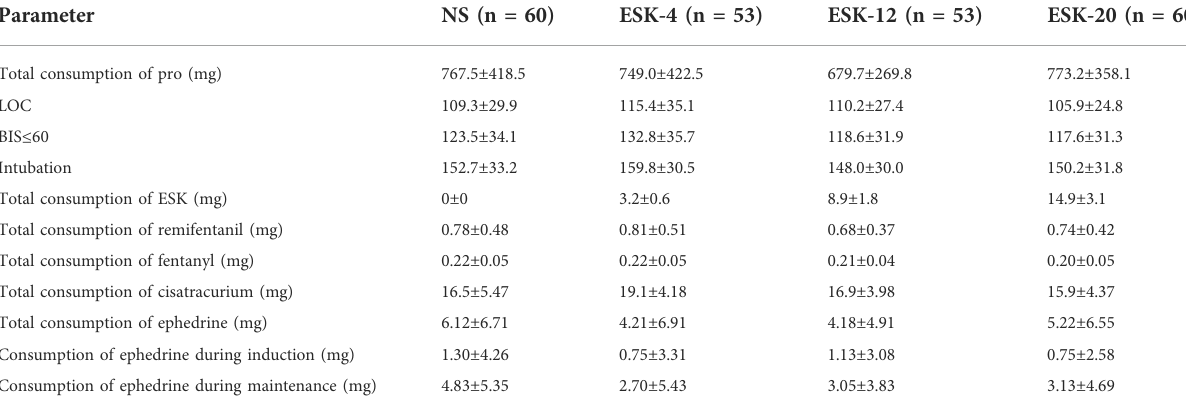
TABLE 4 Consumption of anesthetic and vasoactive drugs.